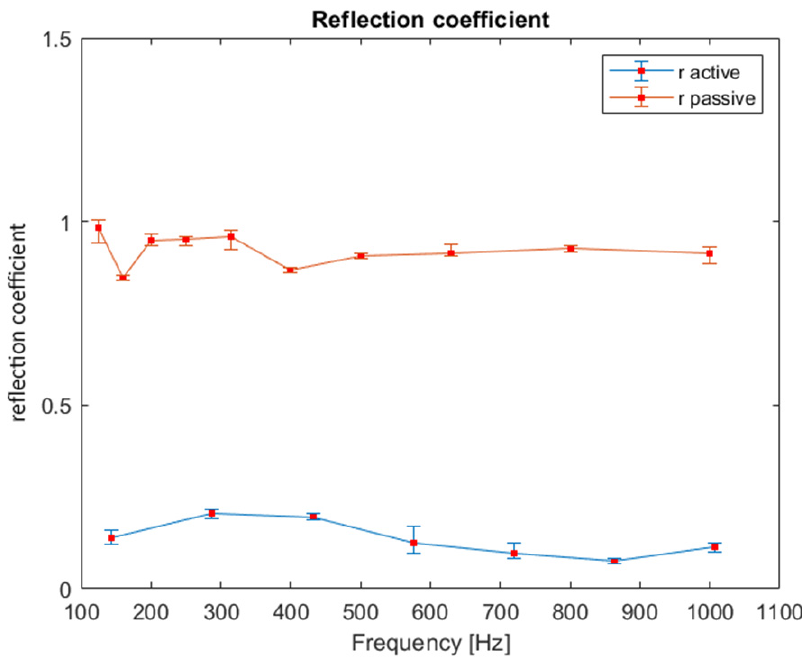
Figure 12. Experimental results of the reflection coefficients with their confidence intervals.